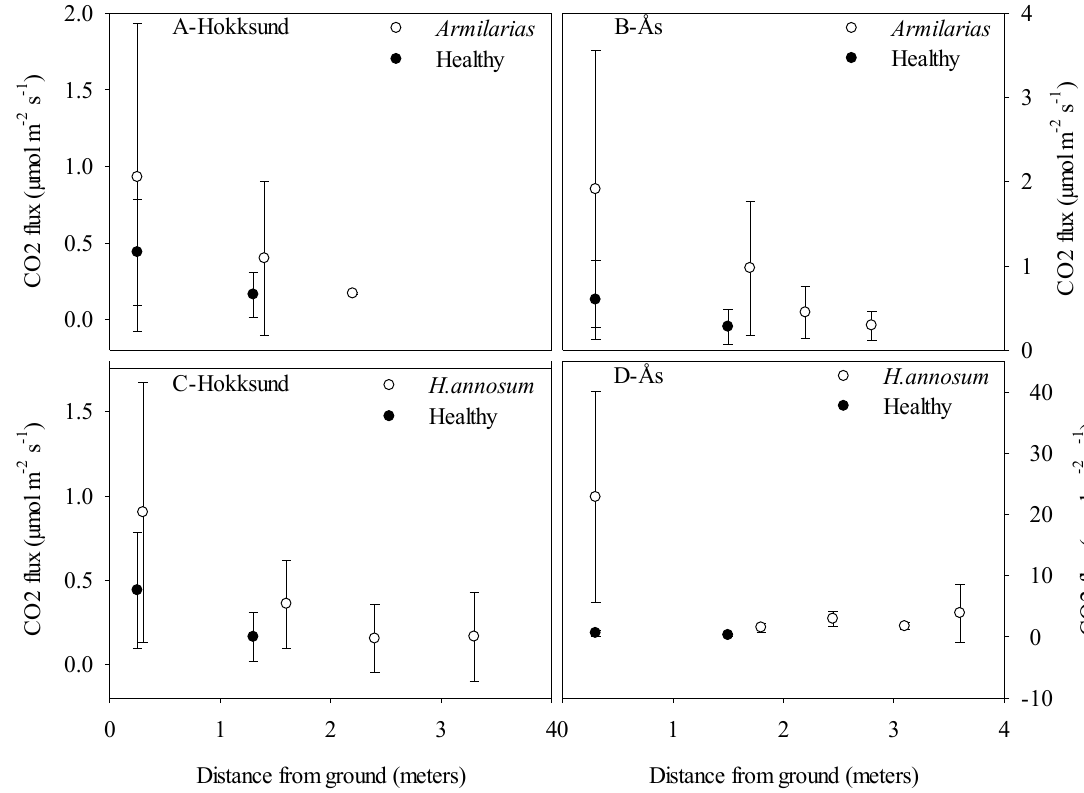
Figure 6. Estimated CO 2 fluxes at different stem heights in healthy trees and trees infected with Armillaria species or H. annosum s.l. Up to 80 gas samples per category